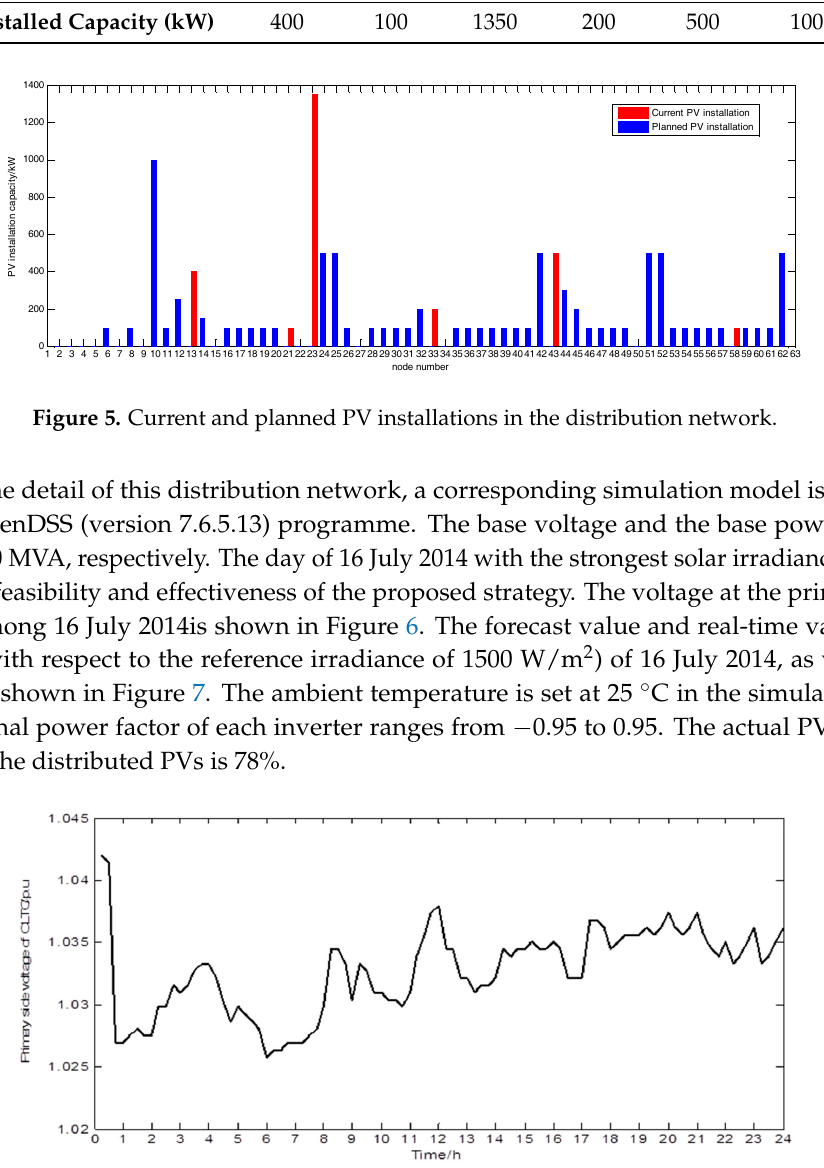
Table 1. Current PV installed capacity table.